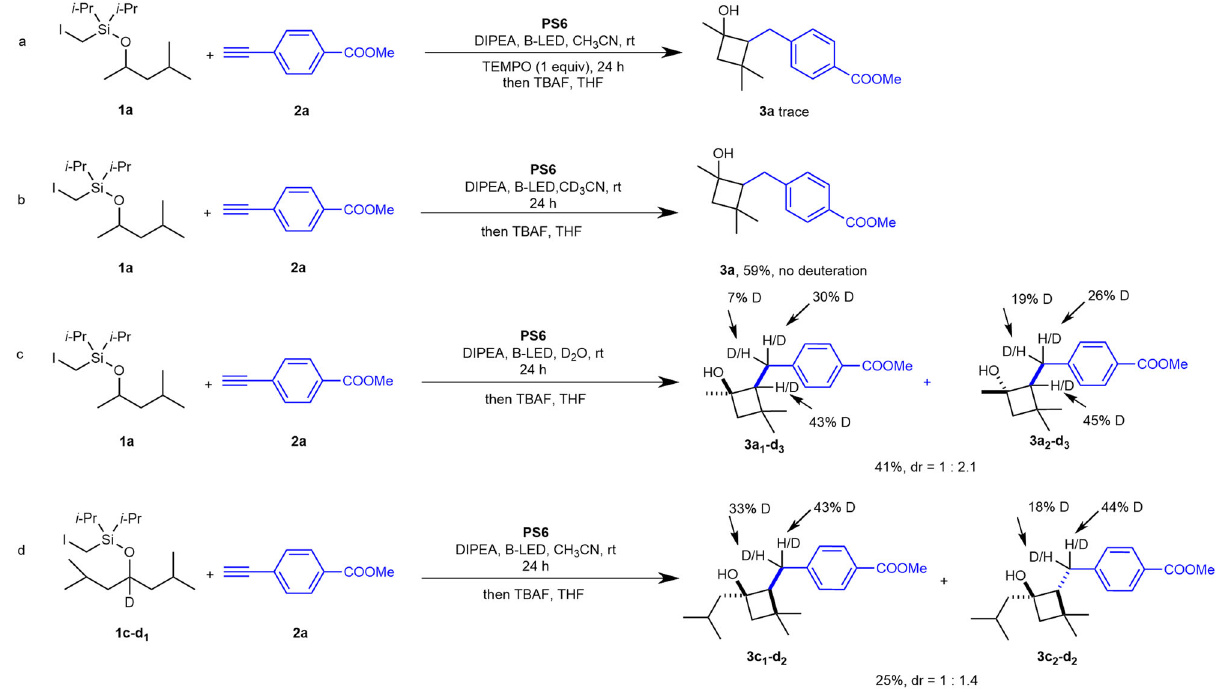
Fig. 4 Mechanistic study. a Radical trapping experiment with TEMPO. b Deuterium experiment with CD 3 CN. c Deuterium experiment with D 2 O. d Deuterium experiment with 1c- d1